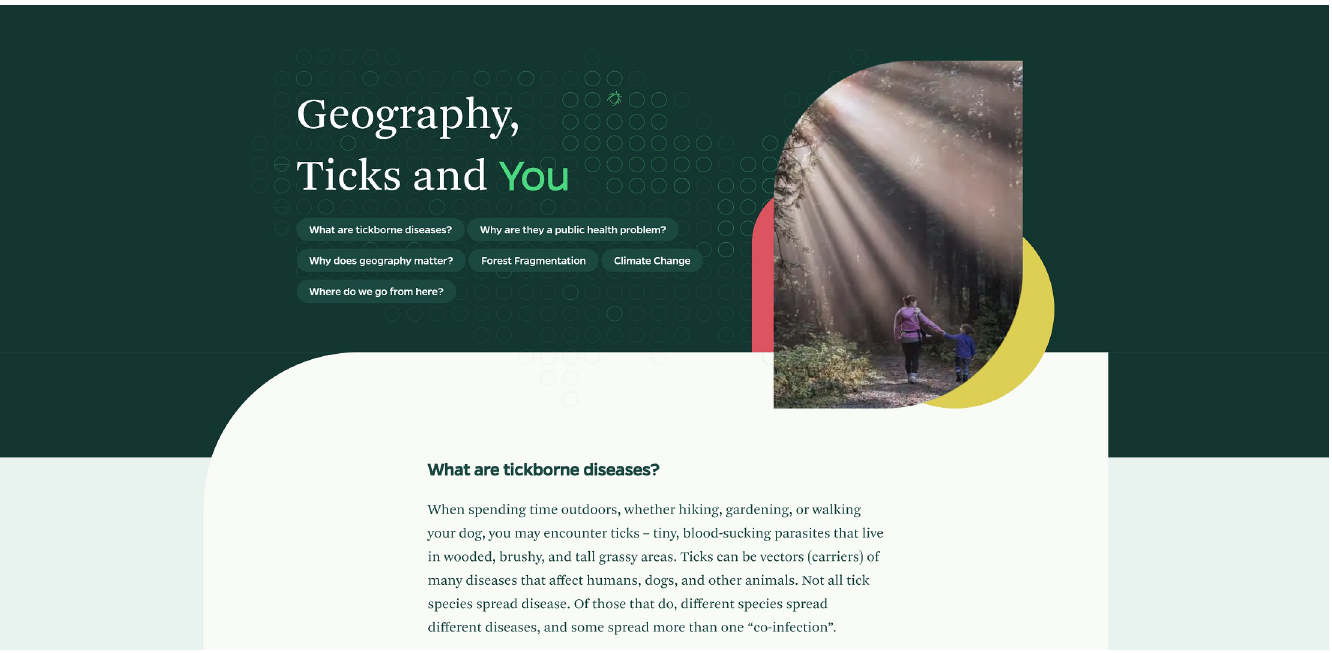
Fig 3. Navigation menu on the “Geography, Ticks and You”